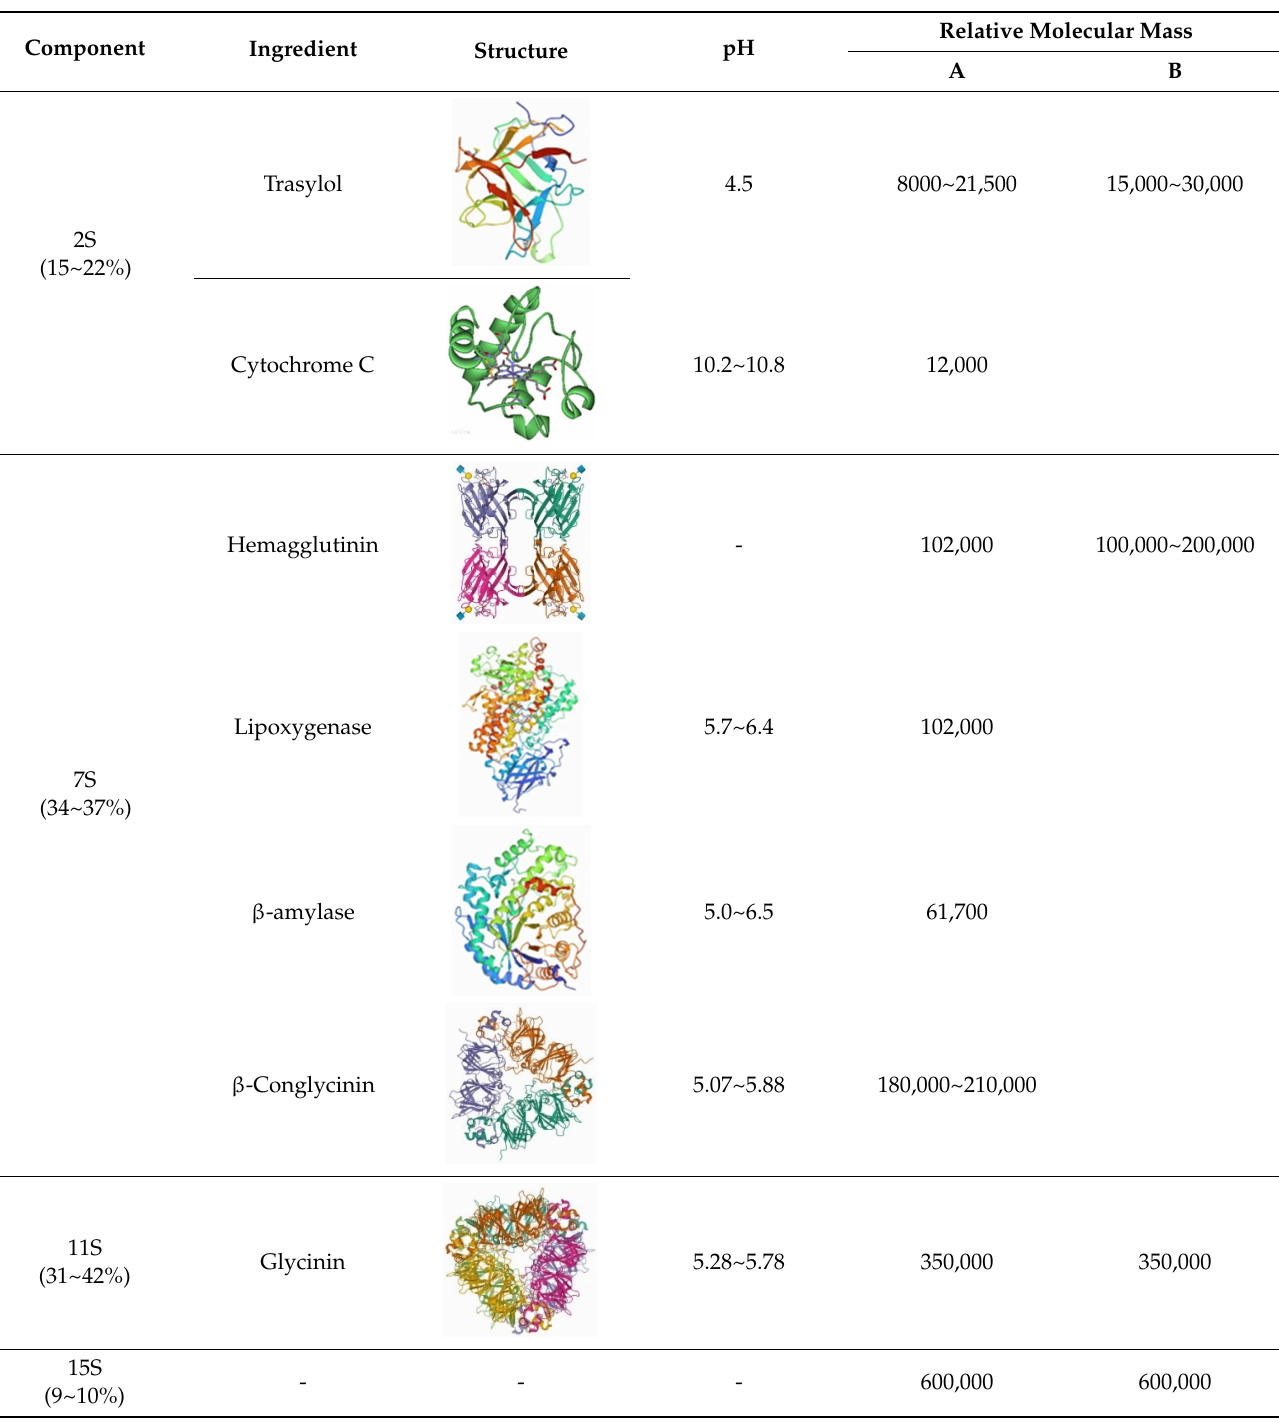
Table 1. Composition, structure, and physiological functions of soy protein [5–10]; Protein Data